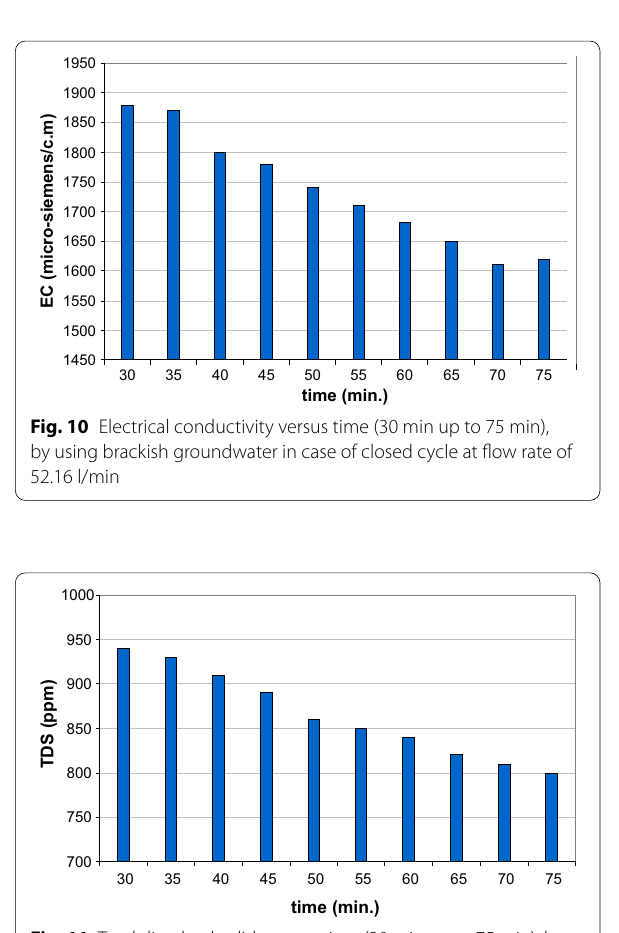
Fig. 11 Total dissolved solids versus time (30 min up to 75 min), by using brackish groundwater in case of closed cycle at flow rate of 52.16 l/min